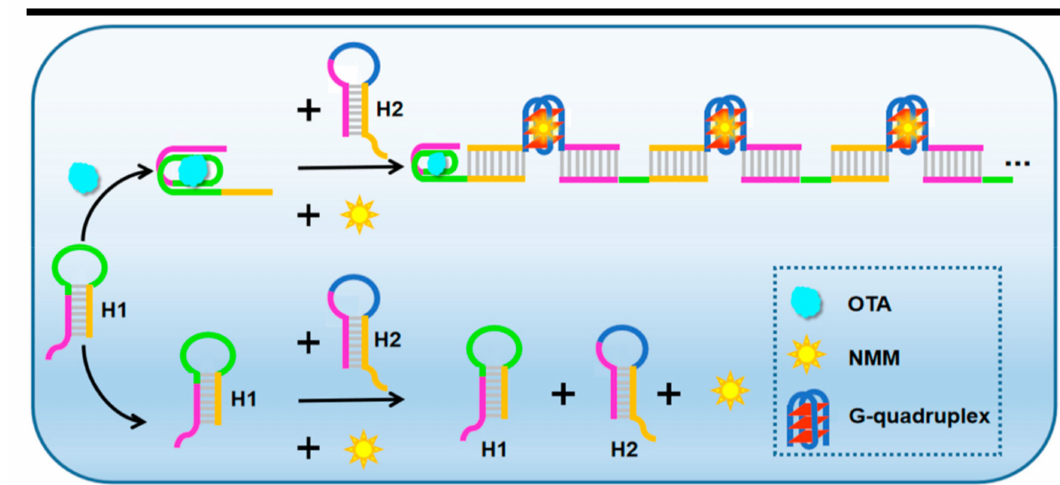
Figure 22. Schematic illustration of a fluorescent aptasensor for the detection of ochratoxin A based on hybridization chain reaction (HCR). Reprinted from reference [139]. This article is an open access article distributed under the terms and conditions of the Creative Commons Attribution (CC BY) license (http://creativecommons.org/licenses/by/4.0/ 25 March